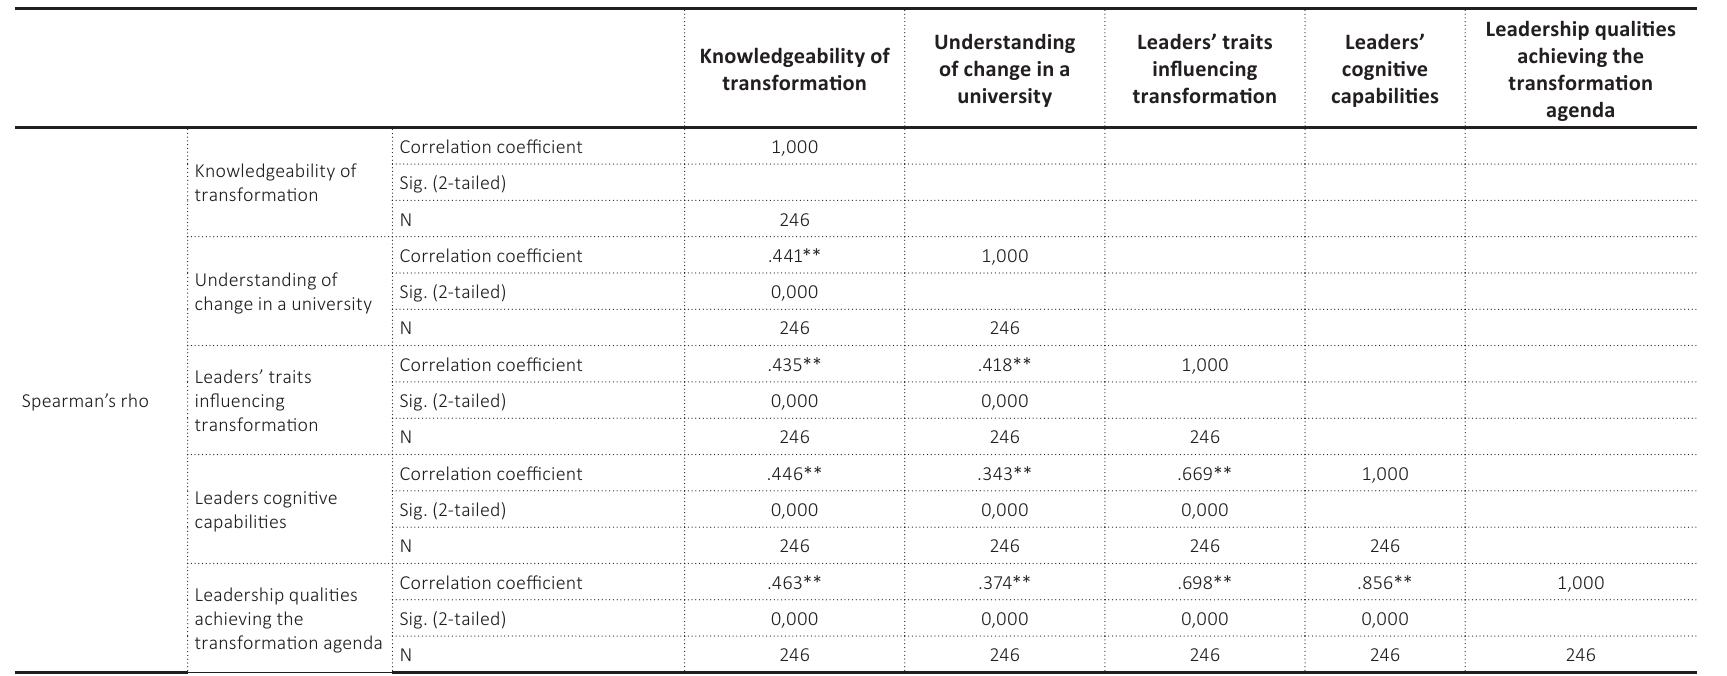
Table 7. Correlations among